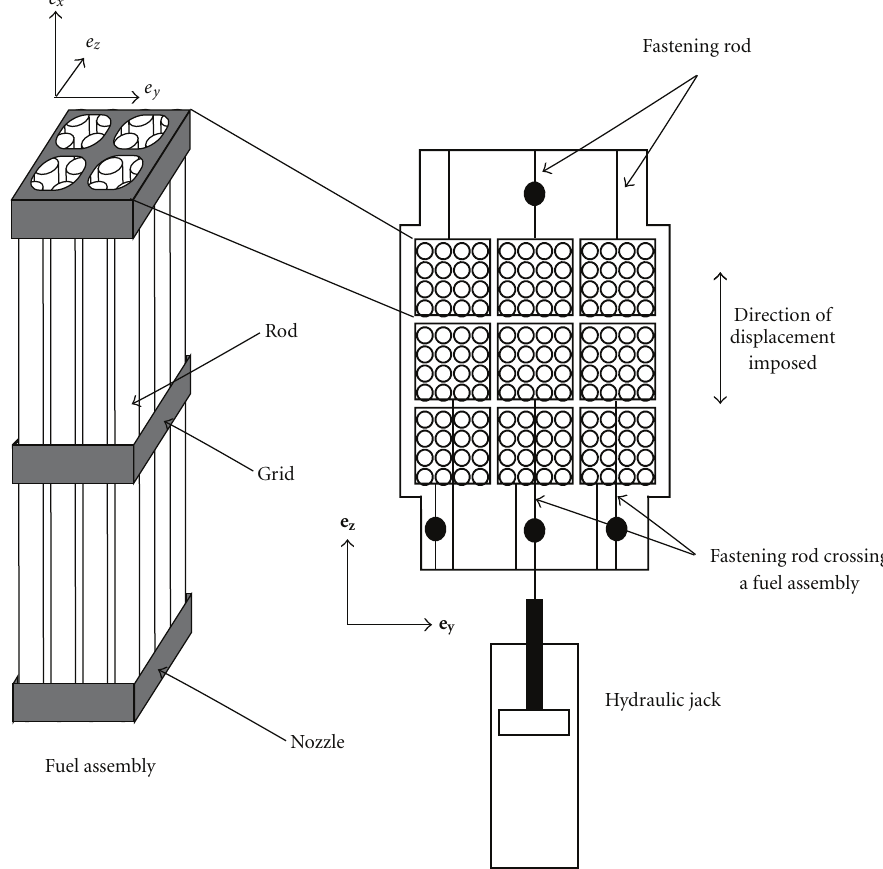
Figure 3: Experimental apparatus (top